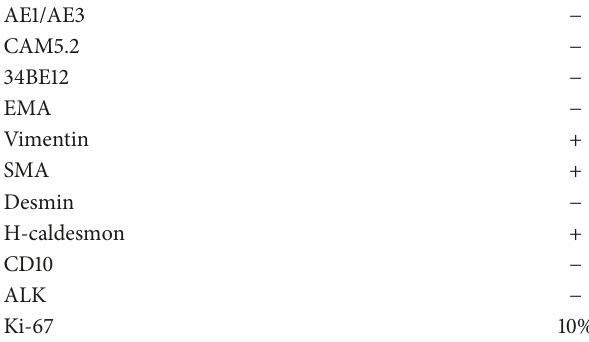
Table 1: Immunohistochemical results of the endocervical